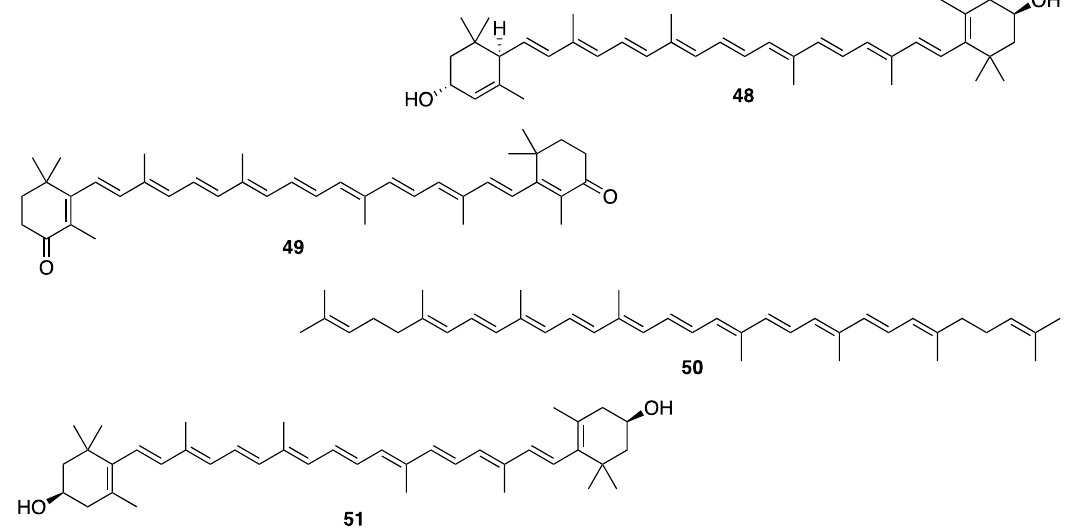
Figure 8. Structures of lutein ( 48 ), canthaxanthin ( 49 ), lycopene ( 50 ), and zeaxanthin ( 51 ).